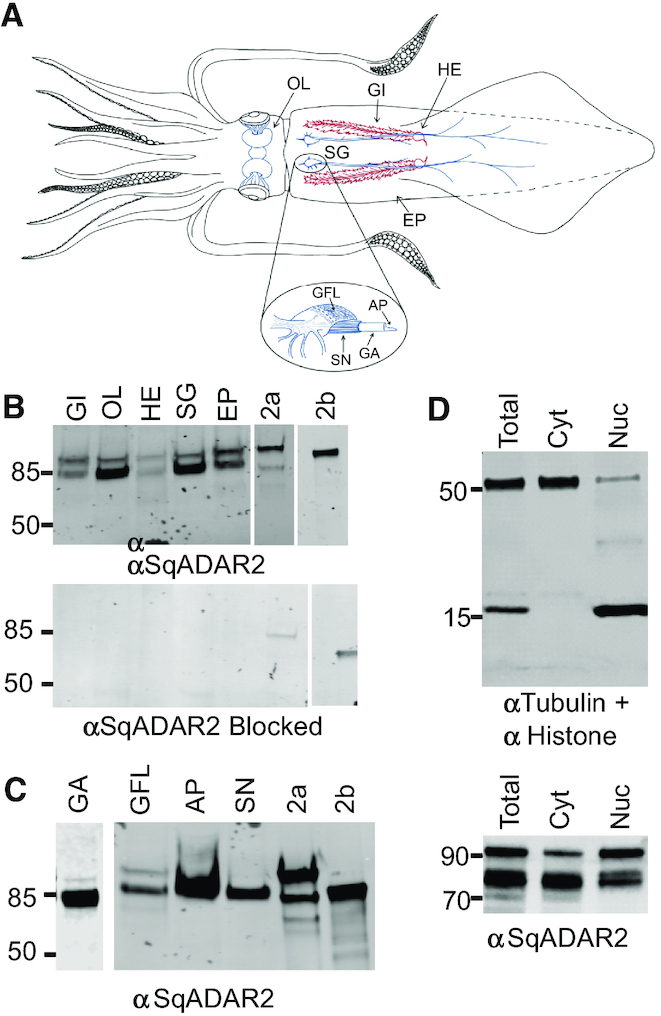
Extranuclear expression of sqADAR2 in squid tissue. (A) A schematic of squid anatomy showing the locations of tissue samples used in this study. OL = optic lobe of the CNS; GI = gill; HE = heart (branchial); SG = stellate ganglion of the PNS (note that the GFL is a part of the SG); EP = epithelium; GFL = giant fiber lobe; SN = small nerves (small diameter axons that form a mesh around the GA); GA = giant axon; AP = axoplasm. (B) Western blot analysis of nervous and non-nervous tissues extracted from D. pealeii and probed with α-sqADAR2 antibody (top panel). Blocked control is also shown (bottom panel). Purified sqADAR2 proteins (2a and 2b) were used as positive controls. (C) Western blot analysis of homogenates from different neuronal tissues extracted from D. pealeii and probed with α-sqADAR2 antibody. (D) Western blot analysis of whole somata samples from the squid SG after total, cytoplasmic and nuclear fractionation. Images were taken using a LI-COR odyssey infrared imaging system; n = 2. sqADAR2a (2a) is 89 kDa, sqADAR2b is 71 kDa, histone is 18 kDa and tubulin is 50 kDa. GI = gill; OL = optic lobe; HE = heart; SG = stellate ganglion; EP = skin epithelium; GA = giant axon; GFL = giant fiber lobe; AP = axoplasm; SN = small nerve fibers; 2a = sqADAR2a; 2b = sqADAR2b.